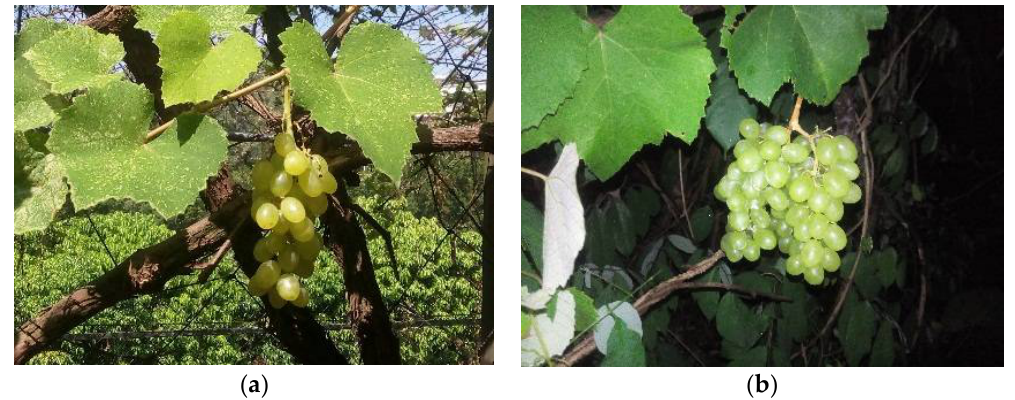
Figure 2. Daytime and night-time grape pictures. ( a ) Daytime grape cluster; ( b ) night-time grape